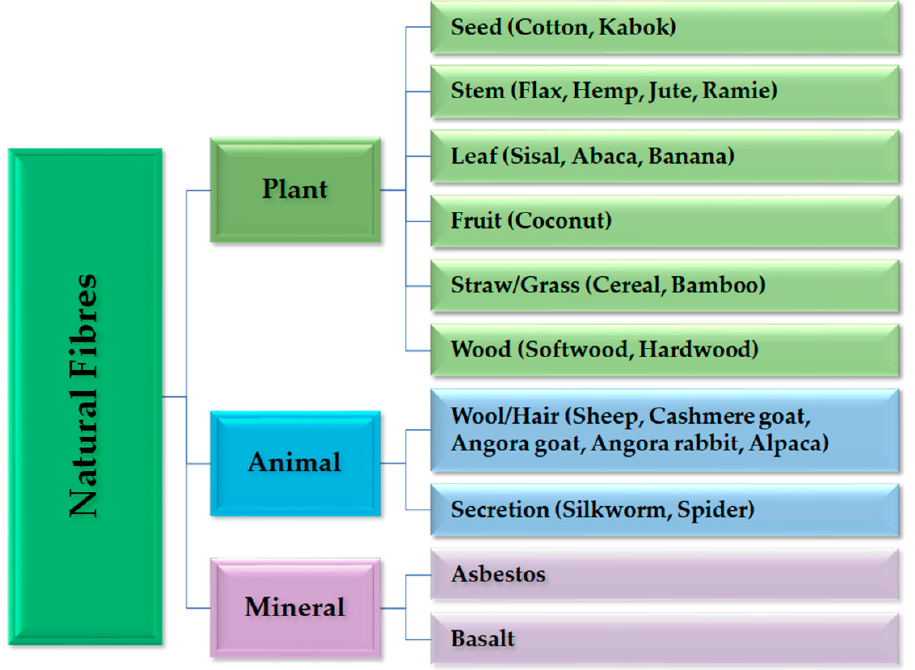
Figure 5. Classification of natural fibres with examples of their origin. This overview excludes nanosized cellulose fibrils and cellulose crystals that are found in bacteria and tunicates.